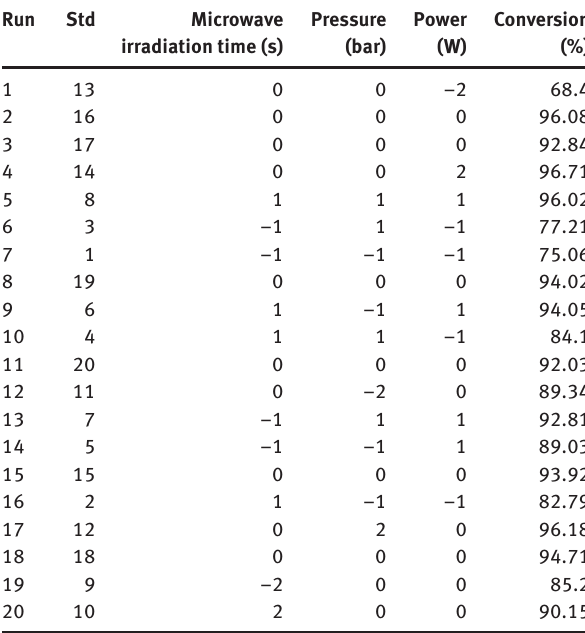
Table 2: Central composite design for three-factor coded conditions.